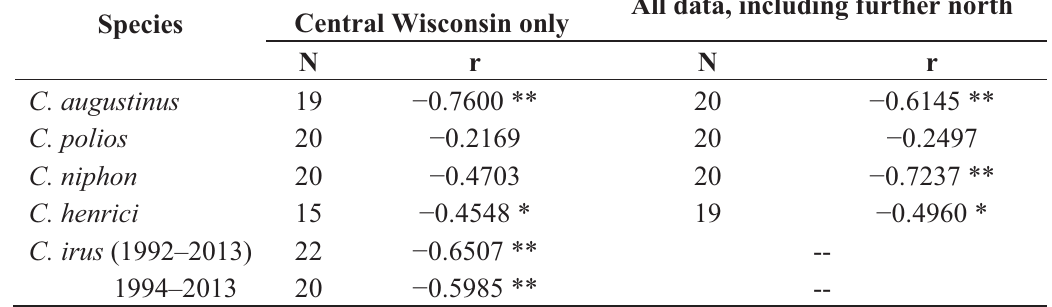
Table 6. Spearman rank correlation coefficients (r) of first observed date for C. irus with the other study species ’ first observed date, calculating dates either using surveys only in central Wisconsin or using all survey data including from northern Wisconsin and